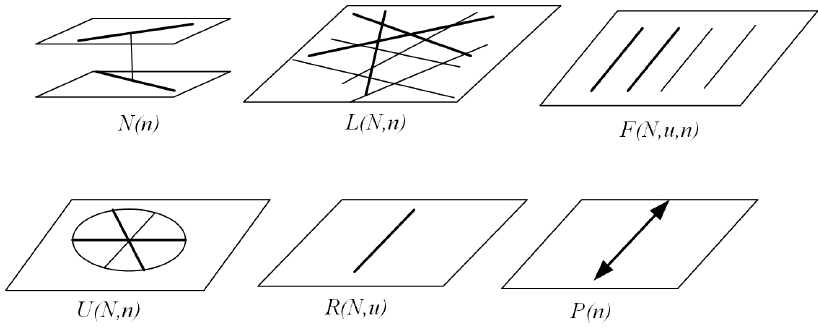
Figure 7. Fundamental building blocks. Table 2. Equivalent freedom FBBs of two flexible units.